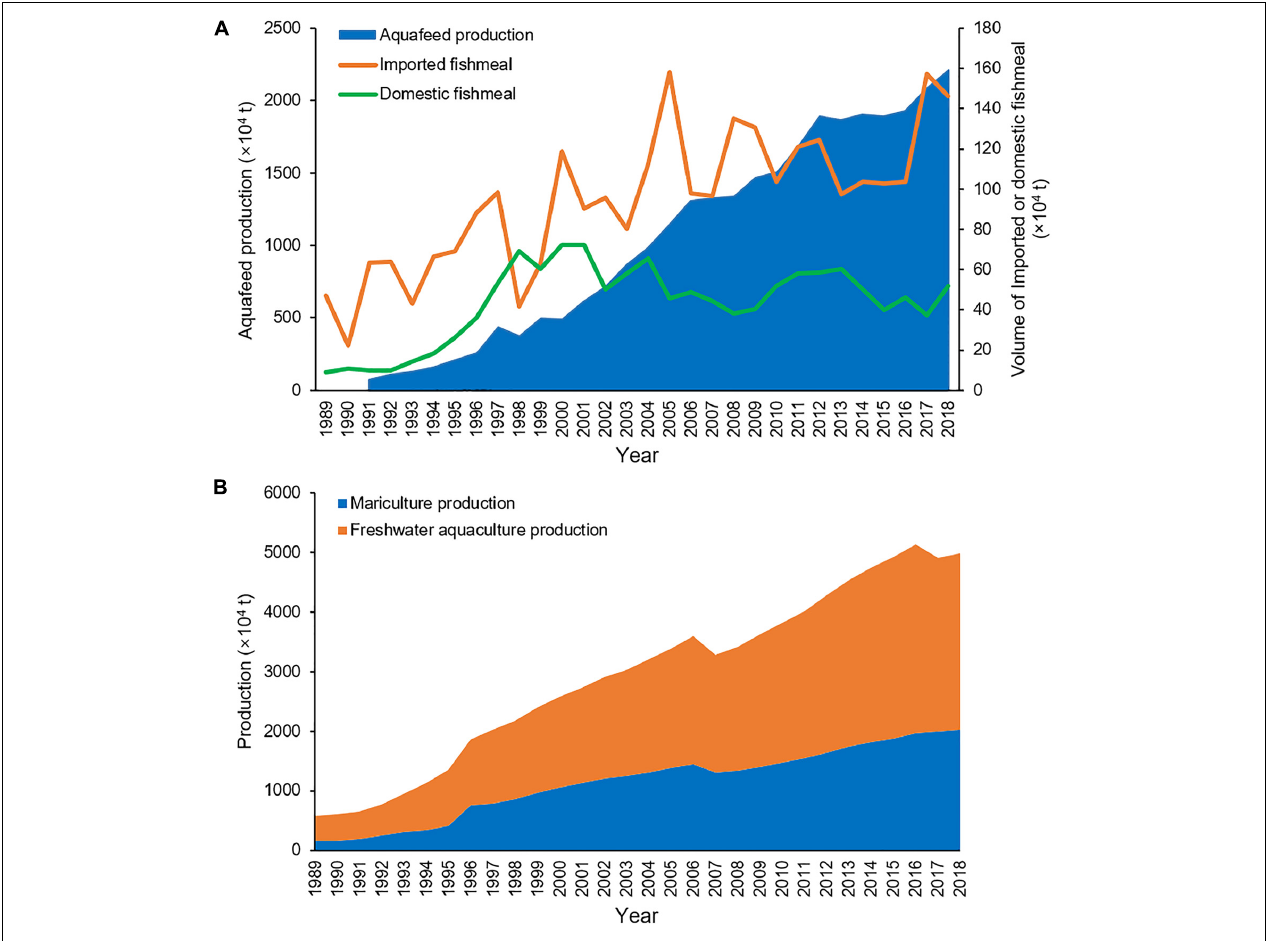
FIGURE 5 | The production of aquafeeds, aquaculture and fishmeal usage over the past 30 years in China. Based on data from China Feed Industry Yearbook (1991–2019), Fishery Statistics Yearbook (1990–2019a) and FAO (2021). Trends in production of aquafeeds, and volume of imported and domestic fishmeal (A) ; Trends in production of mariculture and freshwater aquaculture (B)